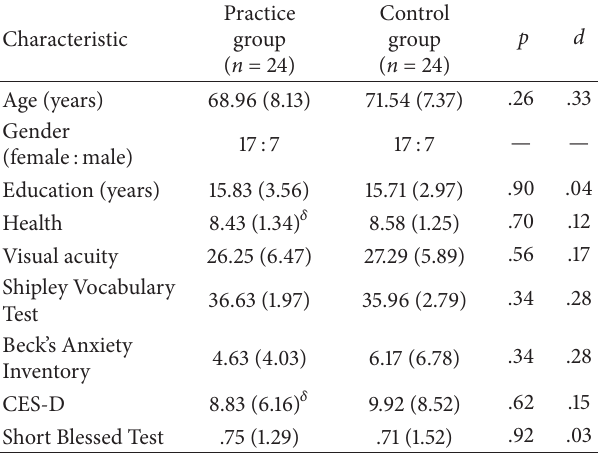
Table 1: Demographic characteristics and baseline cognitive per- formance assessed at pretest separately for the practice group and control